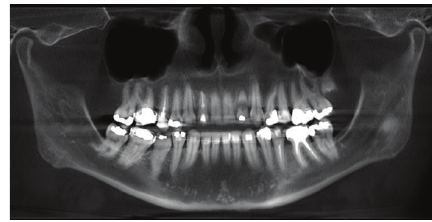
Figure 2: Initial panoramic radiograph.